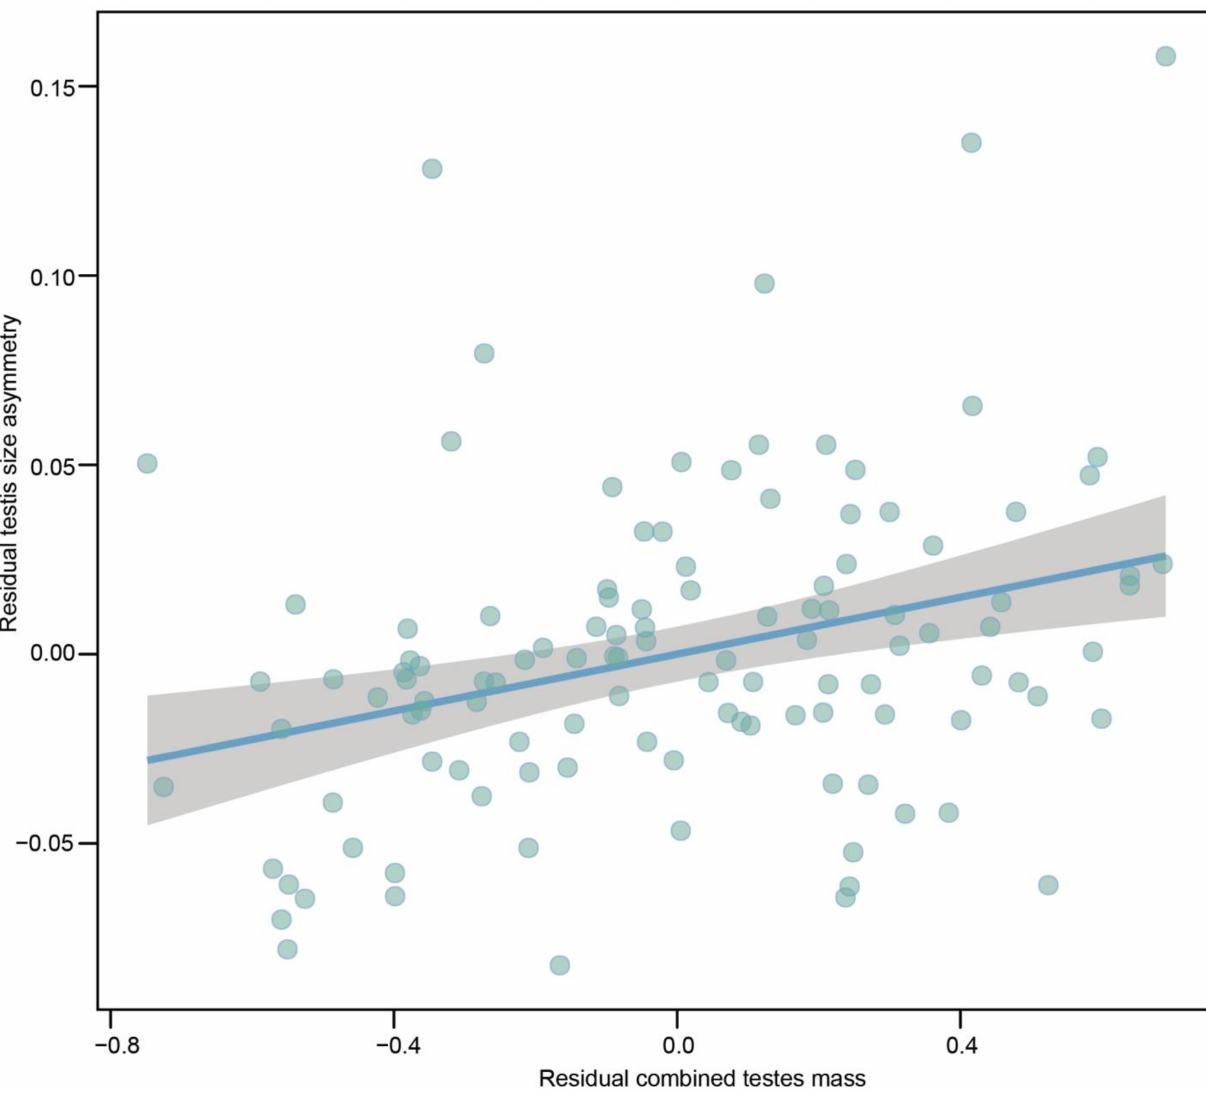
Figure 3. Partial regression plot of residual testes size asymmetry on residual combined testes mass when controlling for phylogeny and SVL across 116 species of anurans. SVL and combined testes mass were log 10 -transformed. Species with higher residual combined testes mass are expected to encounter more intense sperm